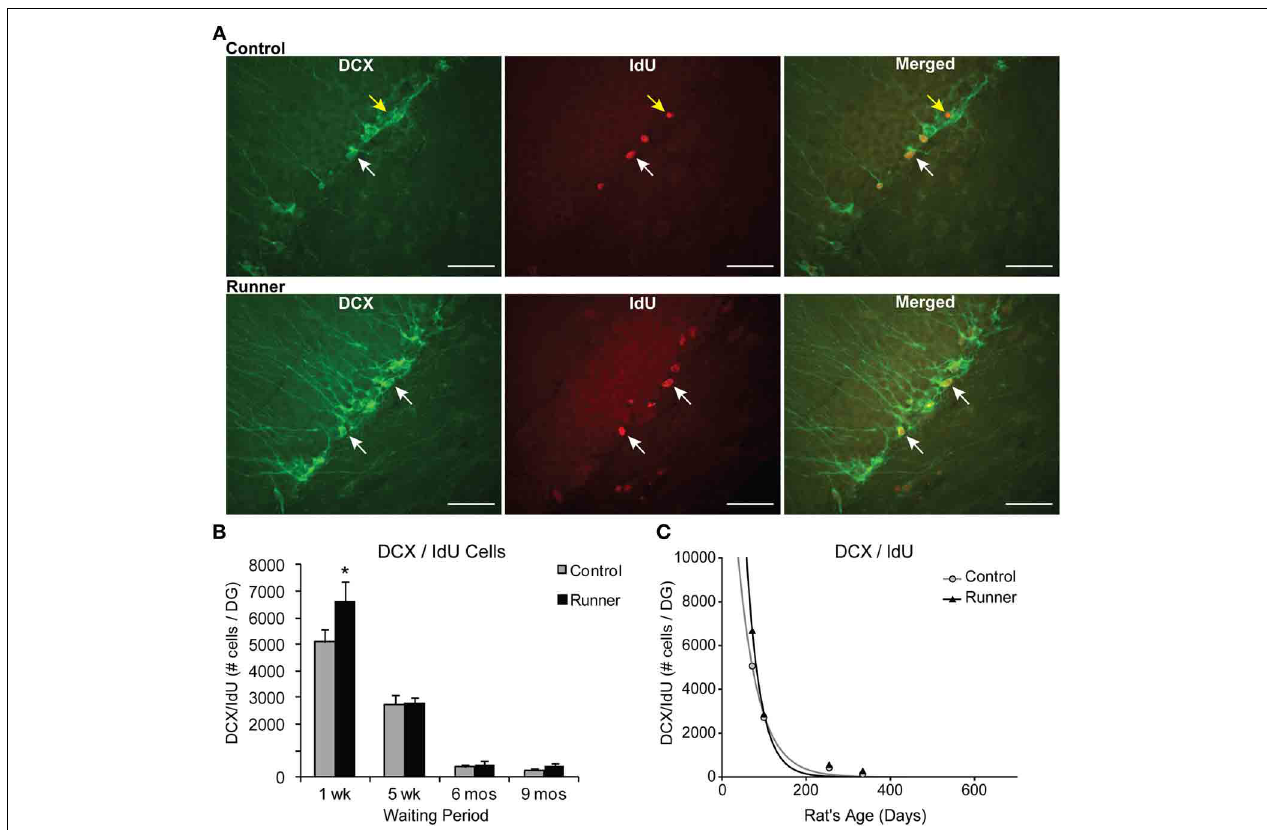
FIGURE 4 | Neuronal differentiation and survival in 1 week old neurons. (A) Confocal microscopic images (40 × ) showing DCX and CldU labeled cells in the DG of 10 week old Control ( top panels ) and Runner ( bottom panels ). White arrows indicate double-labeled cells, and yellow arrow indicates single-labeled CldU cell. Scale bar, 50um. (B) Numbers (mean ± s.e.m.) of dual-labeled DCX/IdU cells. Runners in the 1 week cohort (10 weeks of age)